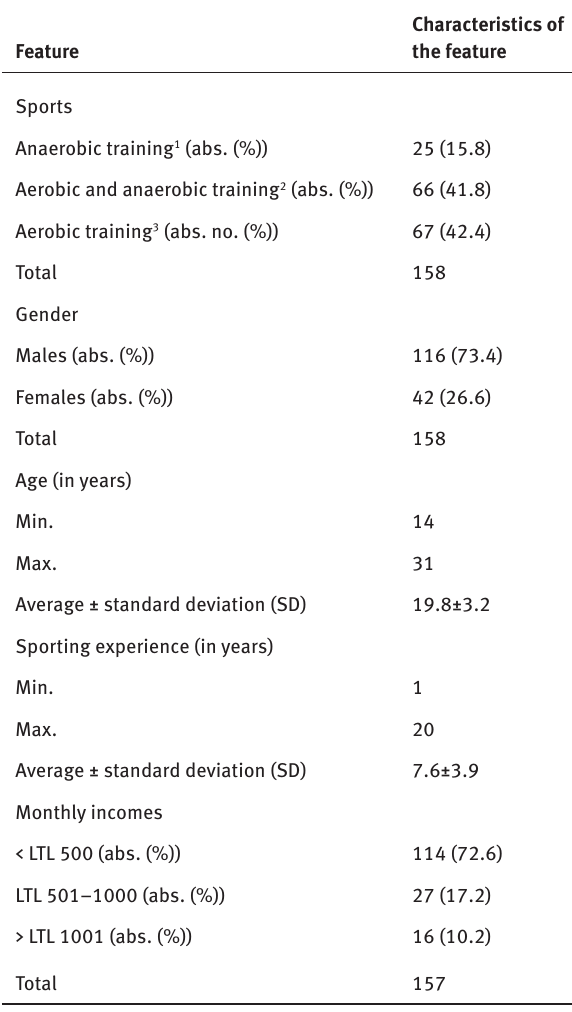
Table 1: Respondents’ characteristics